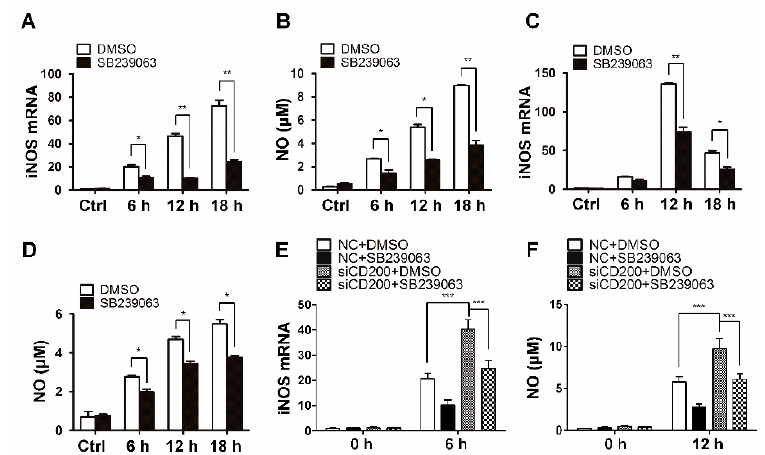
Figure 7. The p38 inhibition largely abolished the effects of CD200 on NO synthesis induced by staphylococcal infection. ( A – D ) Mouse PEMs ( A , B ) or BMDMs ( C , D ) were pre-treated with SB239063 (10 µ M, 0.5 h) or vehicle (DMSO), and then treated with S. aureus for indicated time periods (0–18 h). The mRNA level of iNOS was detected by qPCR, and the concentration of NO in culture supernatants was determined using Griess reagent. ( E , F ) Mouse PEMs were transfected with CD200 siRNA or NC for 48 h and treated with SB239063 or vehicle (DMSO) for 0.5 h. Cells were then infected with S. aureus for indicated time periods (0–12 h). The mRNA level of iNOS and the concentration of NO in culture supernatants were analyzed. Results are expressed as the mean ± SD of three independent experiments; * p < 0.05, ** p < 0.01, *** p < 0.005.